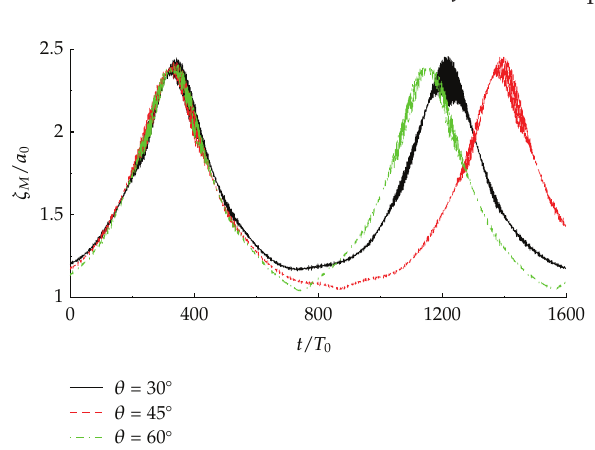
Figure 4: The maximum wave crest histories of Stokes modulated wave train for ε 0 (cid:7) 0 . 05, r 1 (cid:7) 0 . 1 with di ff erent initial